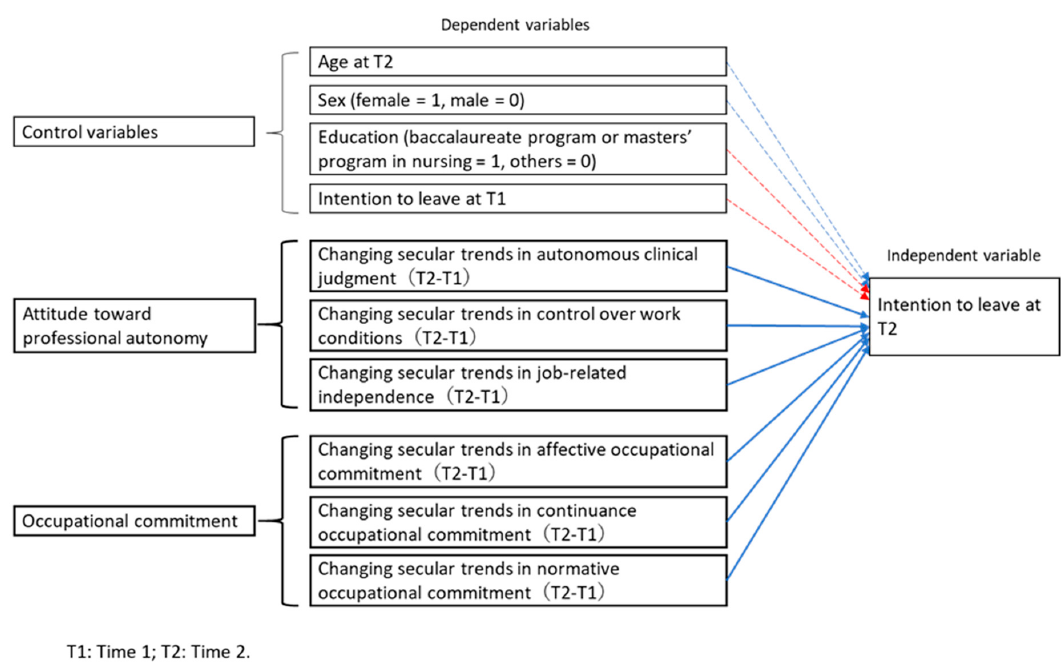
Figure 1. The organization of the variables in this study and their connections to each other. The solid blue arrow points to the hypothesis that the intention to leave at T2 decreases with increasing changes in secular trends in all subscales of nurses’ professional autonomy and OC (occupational commitment). The blue dotted arrows represent the results of previous studies—that older and female nurses have lower intentions to leave, and the red dotted arrows show that the higher the educational background and increase in intention to leave at T1, the higher the increase in intention to leave at T2.